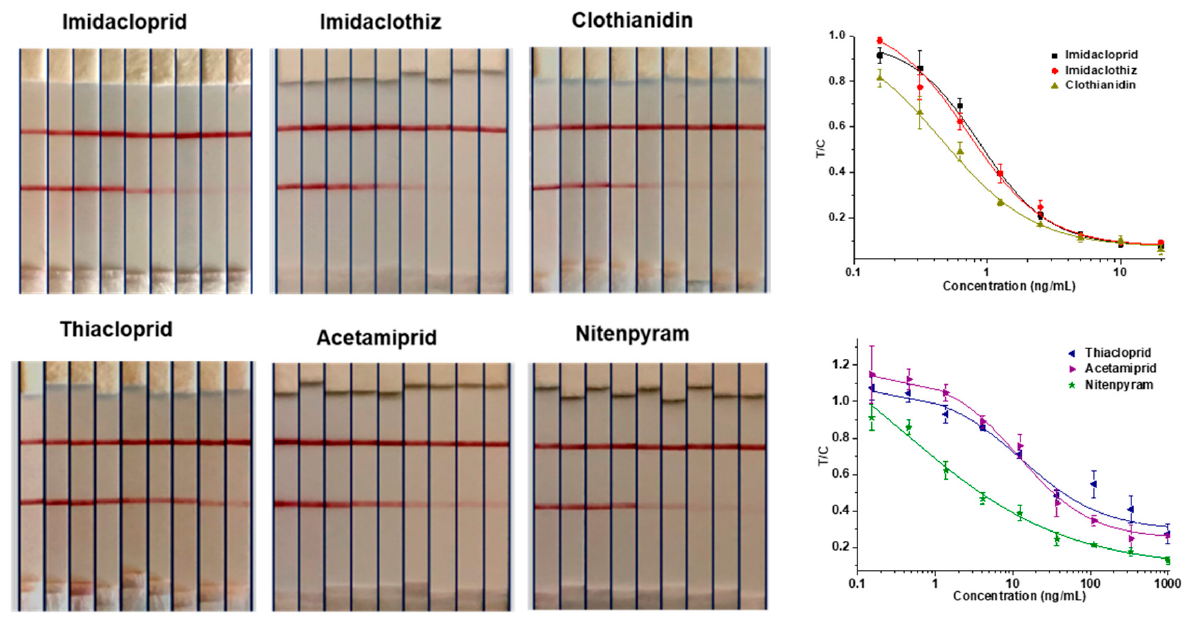
Figure 5. GNIS test for serial concentrations of 6 neonicotinoid pesticides (imidacloprid, imidaclothiz and clothianidin from left to right: 0, 0.16, 0.31, 0.63, 1.25, 2.5, 5, 10, 20 ng/mL; thiacloprid, acetamiprid and nitenpyram from left to right: 0, 0.46, 0.37, 4.12, 12.35, 37.04, 111.11, 333.33, 1000 ng/mL). Standard curves represent the ratio of the T-line to the C-line (T/C) against analyte concentration. The error bars represent the standard deviations of the data points ( n = 3). Table 3. Average recoveries of sample spiked with 3 neonicotinoid pesticides based on GNIS assays ( n = 3).